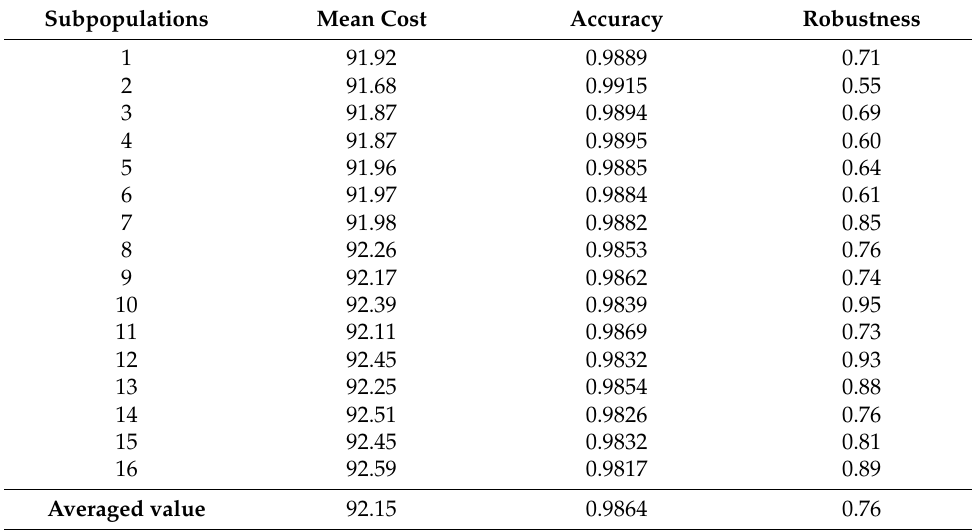
Table 10. Cross-section under biaxial bending. GSRD. Performance